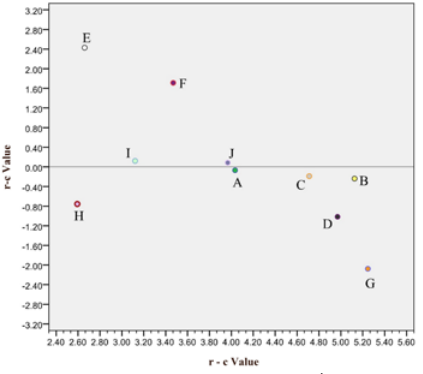
Fig. 2. The impact-relations-map (causal